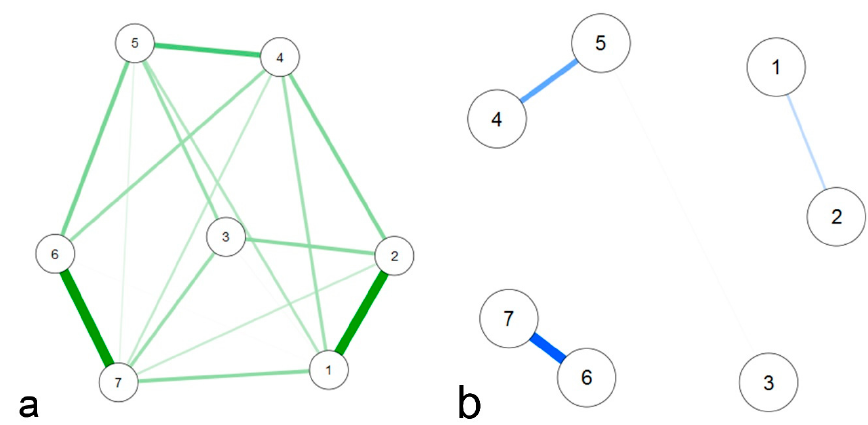
Figure 14. The JASP network graph of correlation of the species richness in seven sites of the Abraham Lincoln Birthplace National Historical Park in similarity level of 50% ( a ), and 90% ( b ). The abbreviations for the sites are the same as in Tables 1 and 2. Line thickness corresponds to the value of the correlation coefficient.